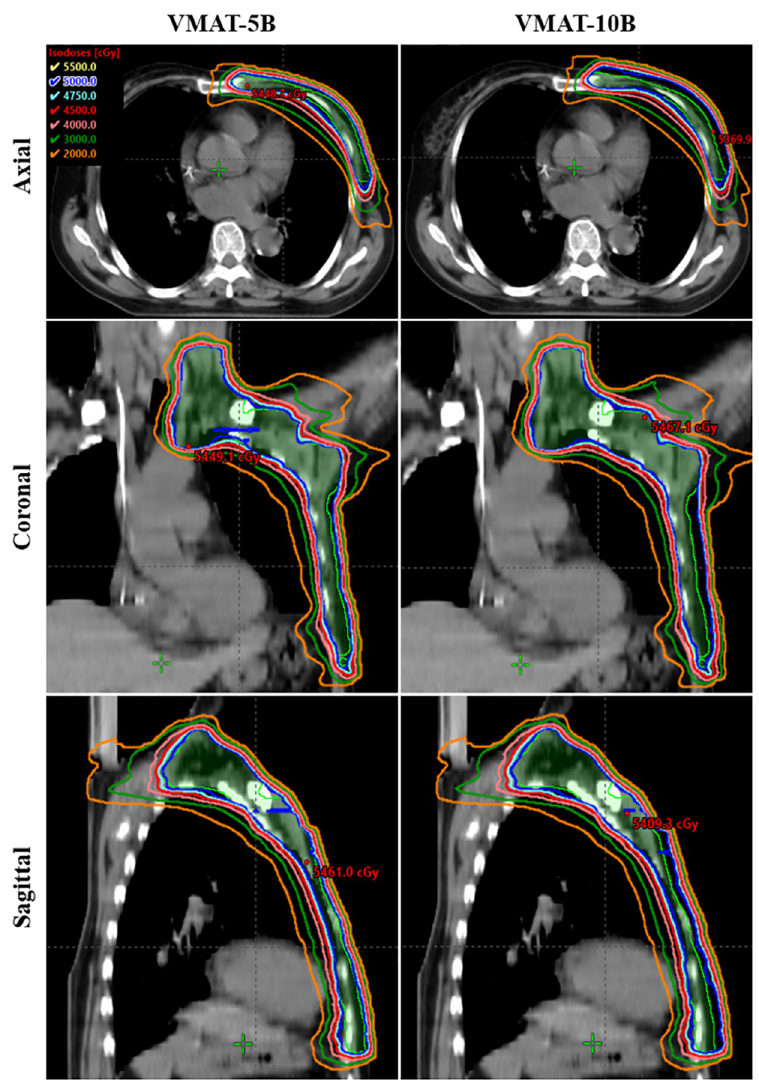
Fig 2. Dose distribution in the axial (upper panels), coronal (middle panels) and sagittal (lower panels) planes for a typical patient with VMAT-5B (left panels) and VMAT-10B (right panels), respectively.